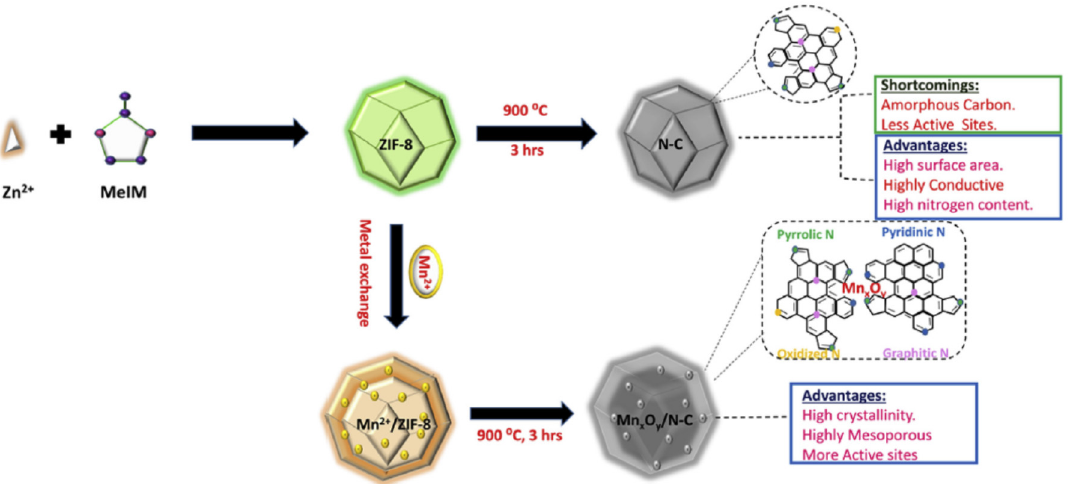
Figure 5. Schematic synthesis of a hybrid Mn x O y / N-C catalyst based on post-synthetic cation exchange. Reprinted with permission from ref. [63]. Copyright (2018) Elsevier.